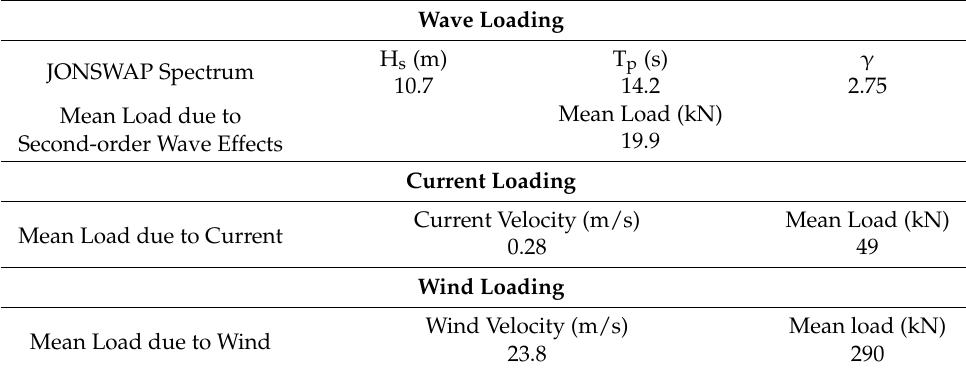
Table 5. FOWT Environmental